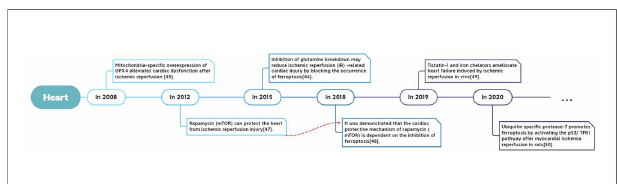
FIGURE 4 | Report of Ferroptosis in cardiac ischemia-reperfusion injury.